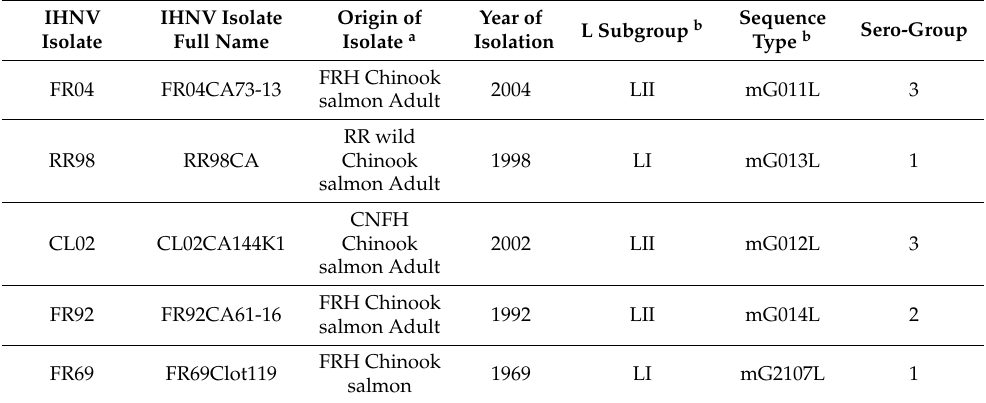
Table 2. Isolates of infectious hematopoietic necrosis virus (IHNV) used in experimental challenge studies. Isolates represent five genotypes and three serogroups from the Feather River (FRH) or Coleman National (CNFH) fish hatcheries in California or the Rogue River (RR) in Oregon. IHNV IHNV Isolate Origin of Year of L Subgroup Isolate Full Name Isolate a Isolation